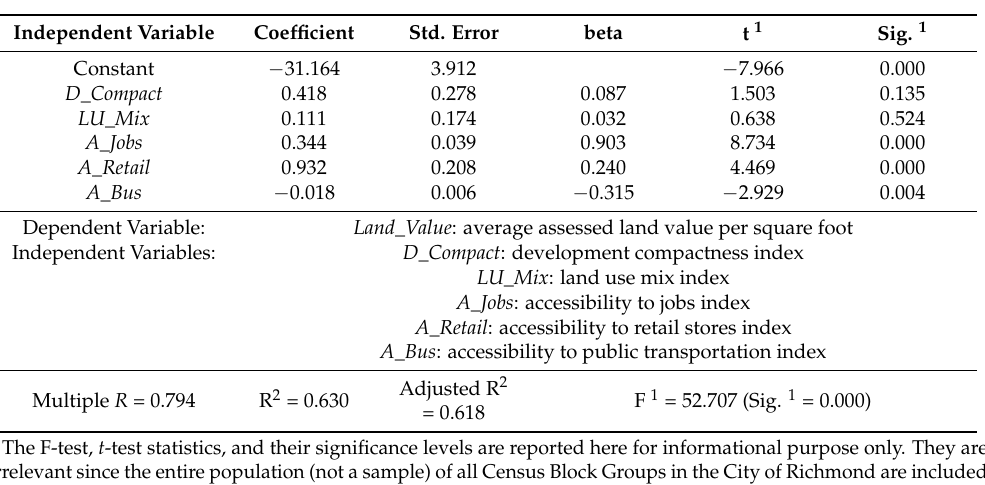
Table 6. Regression analysis of land value on development compactness, land use mix, accessibility to jobs, retail stores, and public transportation ( N =